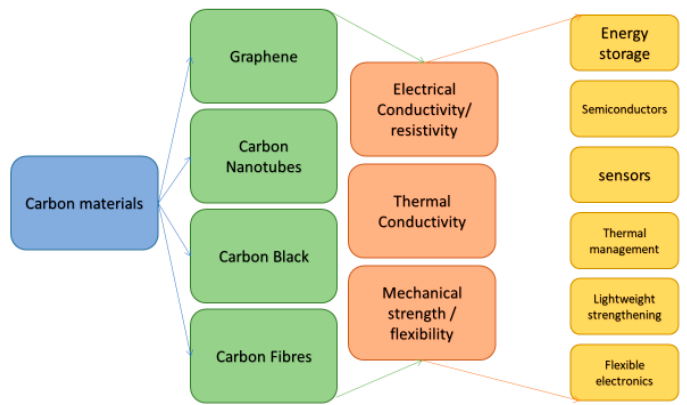
Figure 1. Outline of various forms of carbon (C) used for inks in additive manufacturing and conventional printing techniques, along with their beneficial properties and potential uses.